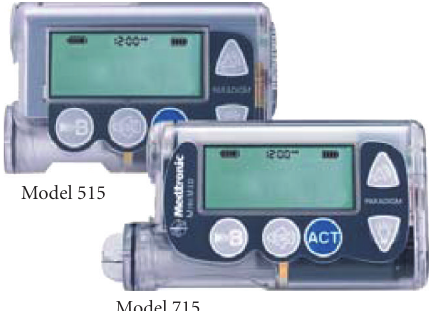
Figure 3: Another example of insulin pumps of Medtronic. A pro- cessing module has a small display that shows a current rate of an exogenous insulin infusion. It also has several control buttons just below the display. Two of these buttons are used to manage a current insulin infusion rate.